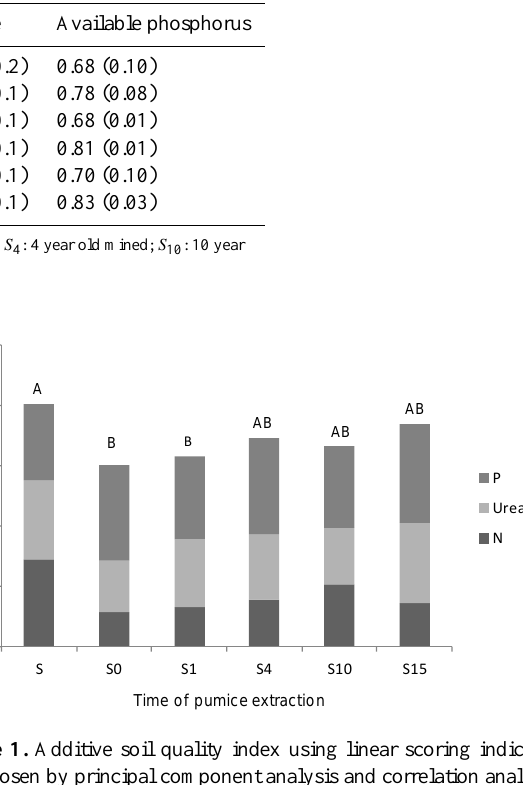
Table 5. Comparison of treatment means and standard deviations (in parentheses) of measured indicator values with linear transformed scores used for PCA and correlation analysis-chosen minimum data set (MDS) variables.